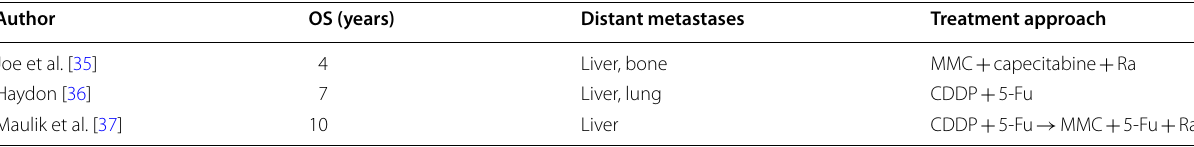
5-FU 5-fluorouracil, CDDP cisplatin, MMC mitomycin C, OS overall survival, Ra radiation